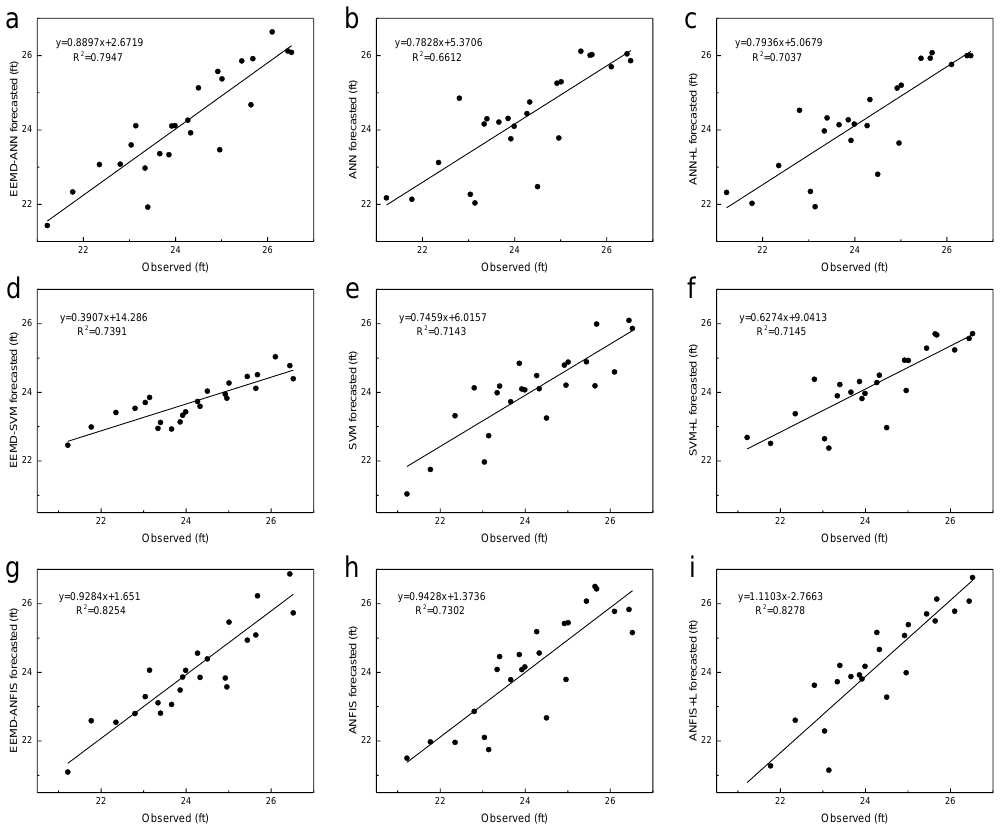
Figure 15. Observed and predicted groundwater levels at the STL185 observation well using ( a ) EEMD-ANN; ( b ) ANN; ( c ) ANN+L; ( d ) EEMD-SVM; ( e ) SVM; ( f ) SVM+L; ( g )